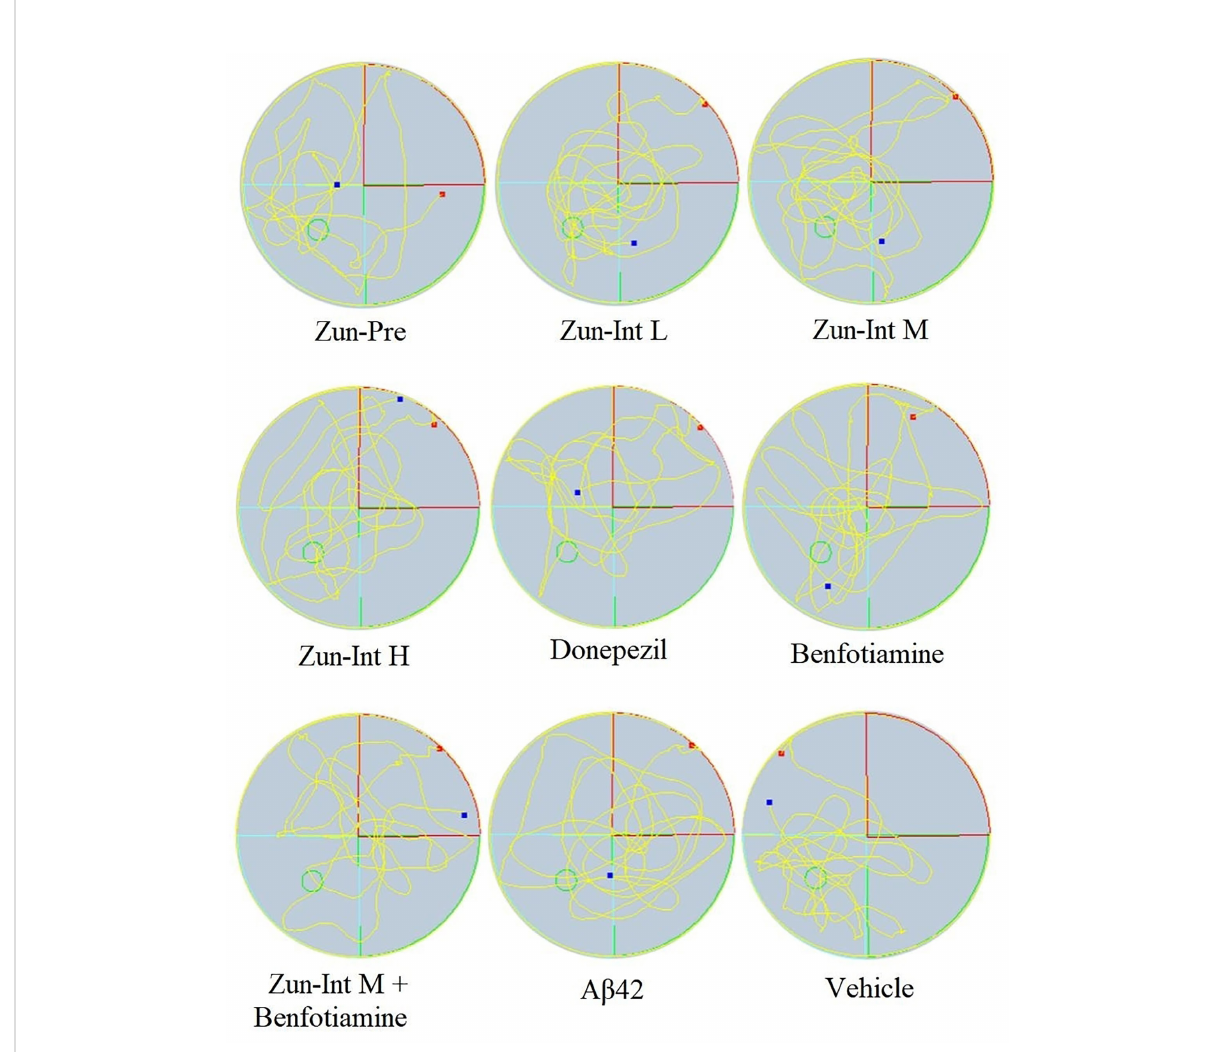
FIGURE 4 Experimental trajectory of spatial exploration of mice in different treatment groups. Compared with AD model mice (A b 42), activities in the original platform location were more frequent and the time stay in the quadrant in the Vehicle group, Zun-Pre group, Zun-Int L group, Zun-Int M group, and benfotiamine group (P < 0.05). The red dots represent the starting position of mouse swimming, and the blue dots represent the swimming end position of